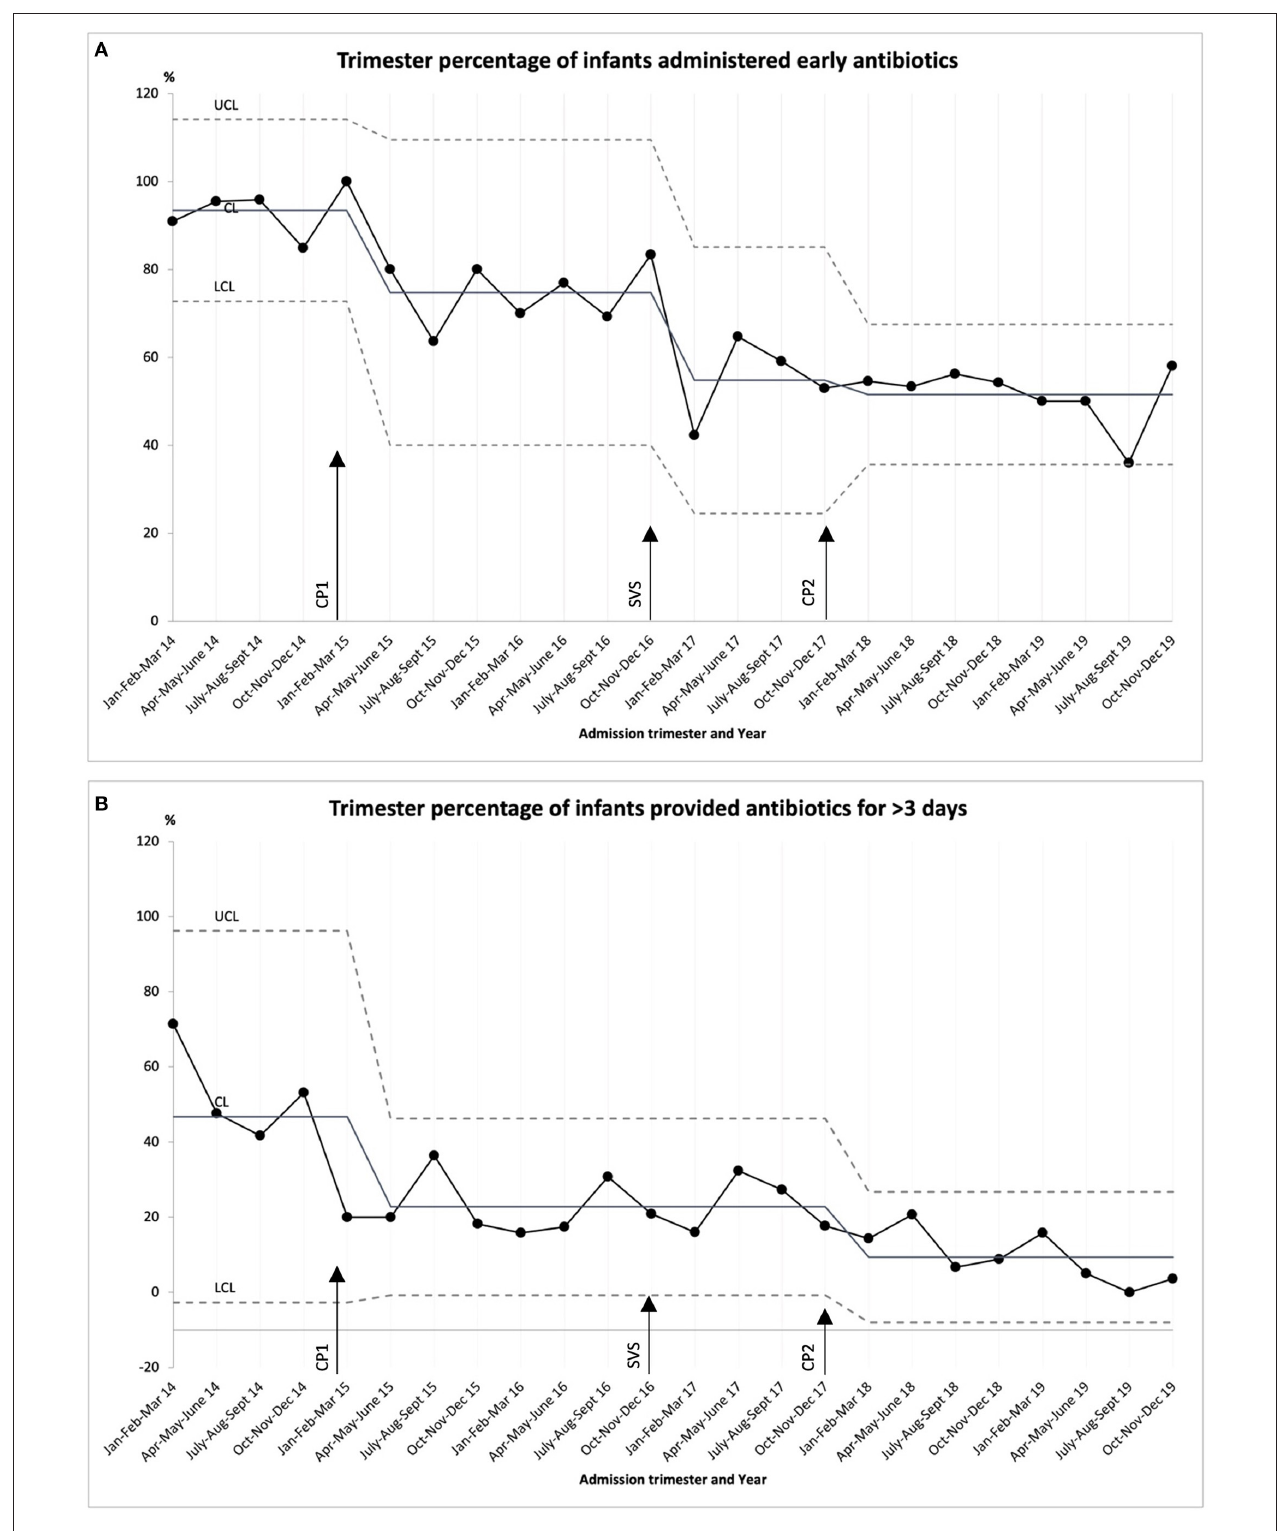
FIGURE 1 | Statistical process control (SPC) chart for VLBW admitted to the NICU between 2014–2019. (A) Trimester percentage of infants administered early antibiotics (ampicillin, gentamicin, or cefotaxime on the day of birth or days 1 or 2 after birth). Mean before clinical practice change (CP) 1 (93%) and after CP 2